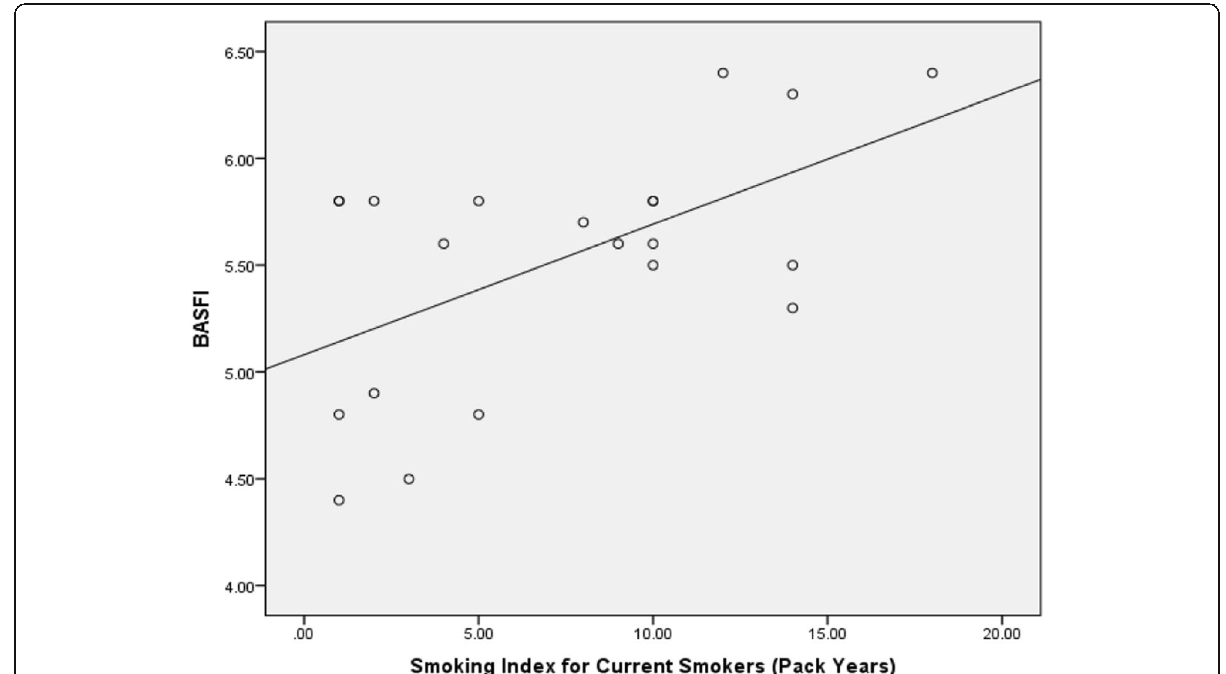
Fig. 1 Correlation between smoking index and BASFI in AS patients. BASFI: Bath Ankylosing Spondylitis functional